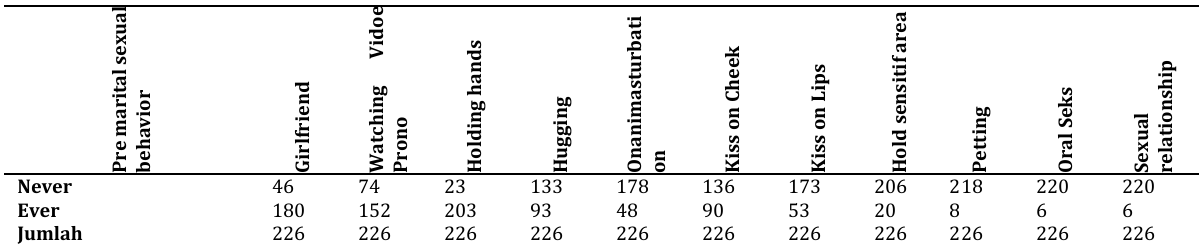
Table 4. Frequency Distribution of the Respondents According to the Form of Premarital Sexual Behavior